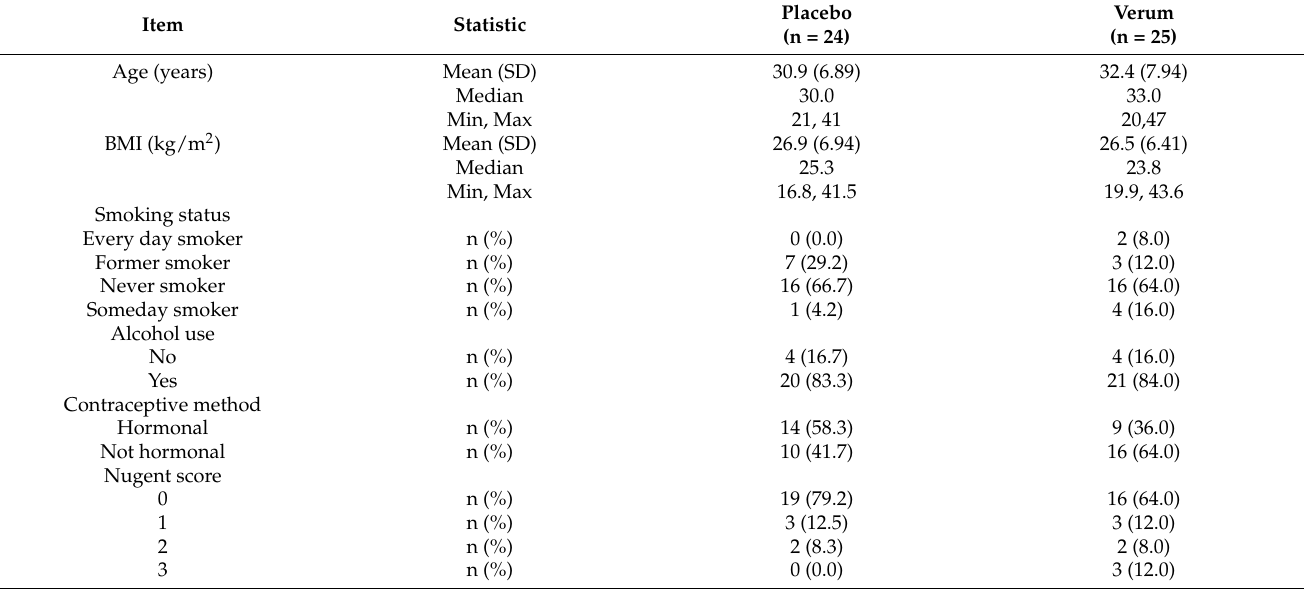
Table 3. Demographic characteristics for the intention-to-treat population. BMI, body mass